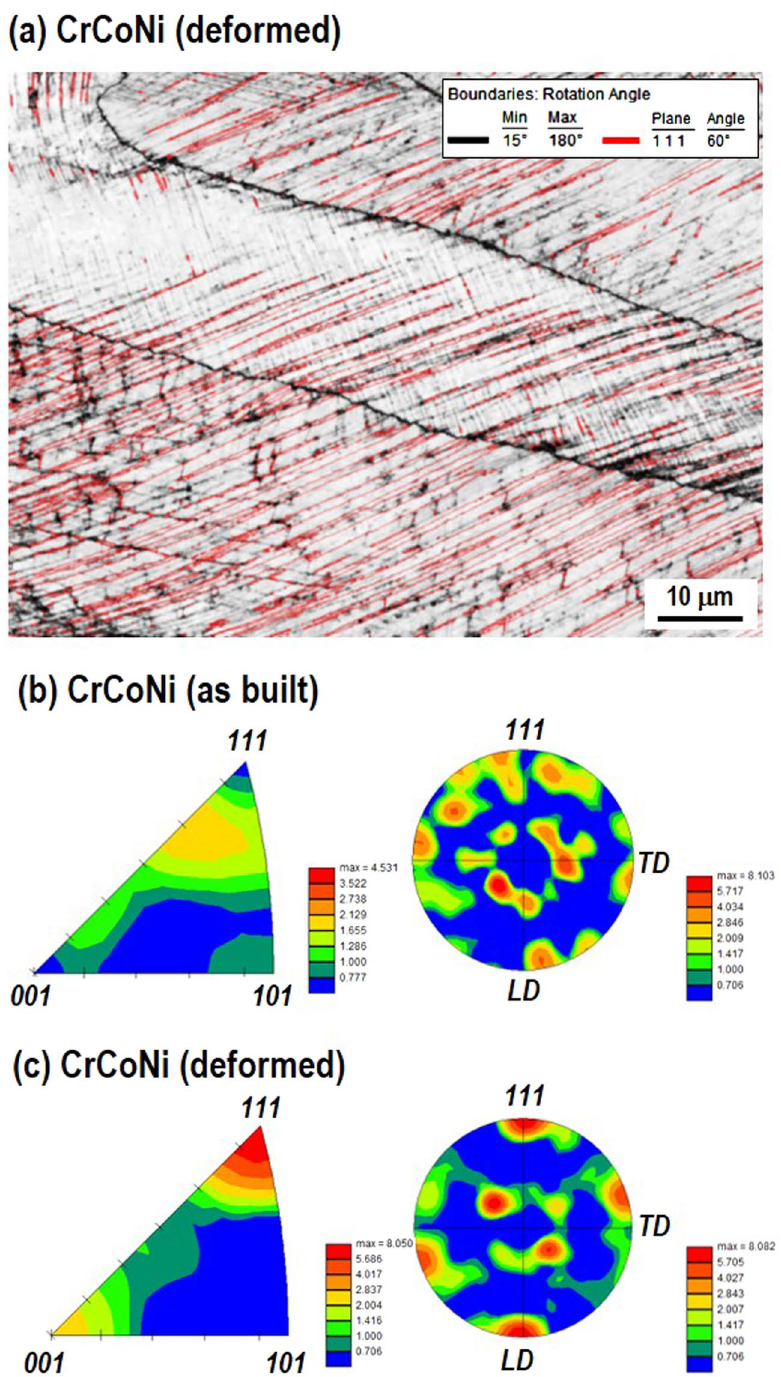
Figure 3. ( a ) EBSD grain boundary map imposed on the pattern quality image of Fig. 2f. Black is high angle grain boundaries and red indicates the misorientation angle of 60° rotation. Inverse pole figures along the longitudinal direction and pole figures of {111} in ( b ) as-built and ( c ) deformed AM CrCoNi